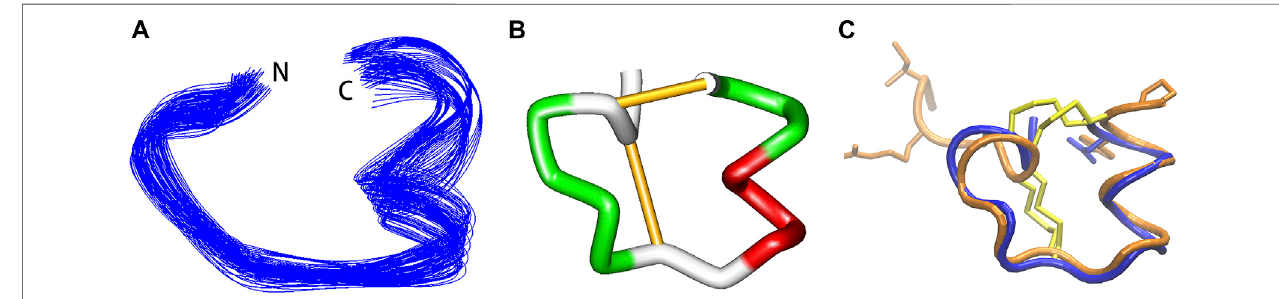
FIGURE 2 | NMR structure of Vt1.27. (A) Backbone ensemble of 20 lowest energy structures. (B) Ribbon representation of the closest-to-mean structure. (C) SuperimpositionofVt1.27(blue)andPl168(orange).ThesidechainsofCysresiduesareshowninyellow.ThesidechainsofdifferentresiduesbetweenVt1.27andPl168 are also shown in (C)